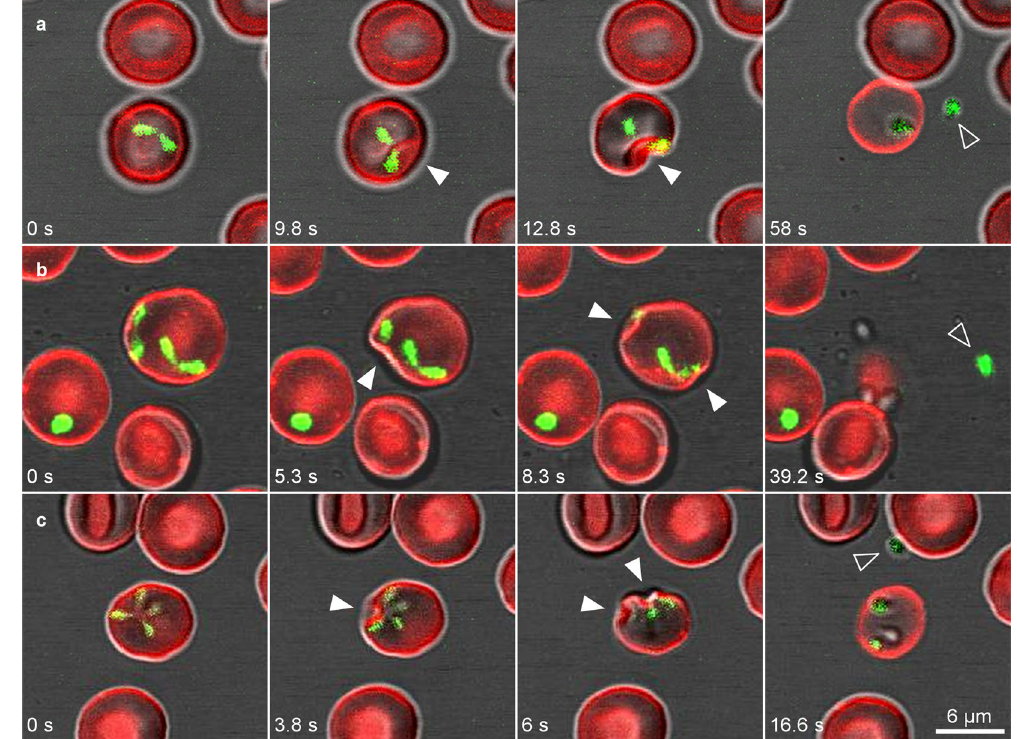
Figure 3. B. divergens intraerythrocytic stages use similar strategies to exit from the infected erythrocyte. Time-lapse image sequences of the egress process of B. divergens parasites stained with MitoTracker (green fluorescent) from infected erythrocytes stained with PKH26 (red fluorescent). ( a ) A merozoite appears to emanate after the dramatic invagination (white arrowheads) of the erythrocyte plasma membrane provoked by the paired pyriform at 9.8–12.8 s. Seconds later, one free merozoite (arrowhead) is released from the erythrocyte while the other one remains within the host cell. ( b ) Egress process of a double paired pyriform. Both paired pyriforms produce successive dramatic depressions (white arrowheads) of the erythrocyte plasma membrane after 5.3 s and 8.3 s causing the discharge of one free merozoite (arrowhead) and the deformation of the erythrocyte. The other three merozoites are retained within or trapped outside the erythrocyte. ( c ) A tetrad causes an initial invagination in the erythrocyte plasma membrane (white arrowheads) at 3.8 sec. The depression and deformation of the erythrocyte become even clearer at 6 s. The tetrad can dissociate into four merozoites inside the cell. Only one free merozoite (arrowhead) is being released from the infected erythrocyte. Time-lapse imaging was captured every 0.753 s. The time-lapsed between each frame is indicated in